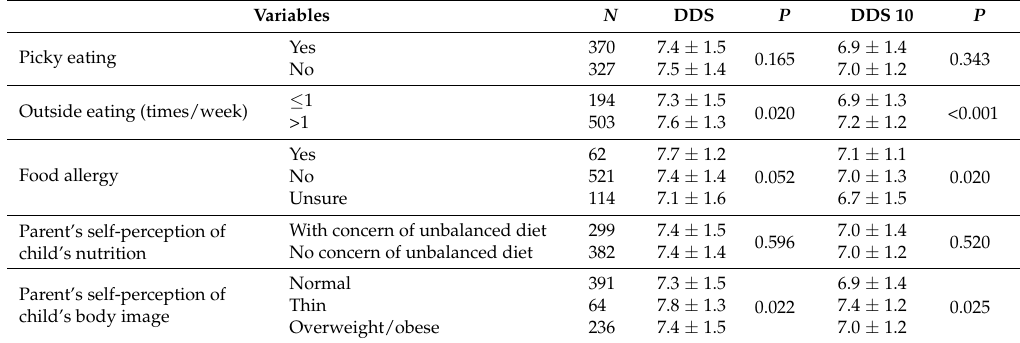
Table 3. The DDS and DDS 10 among Chinese preschool children with different dietary behaviors, food allergy and parent’s self-perception of child’s nutrition and body image (Mean ±